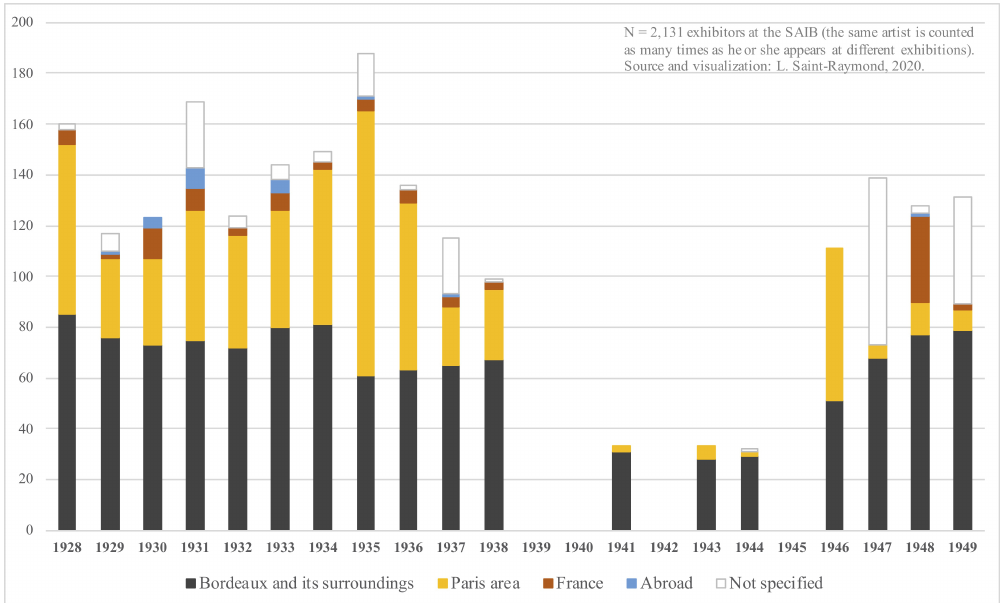
Figure 6. Number of exhibitors at the SAIB, according to the address they gave in the